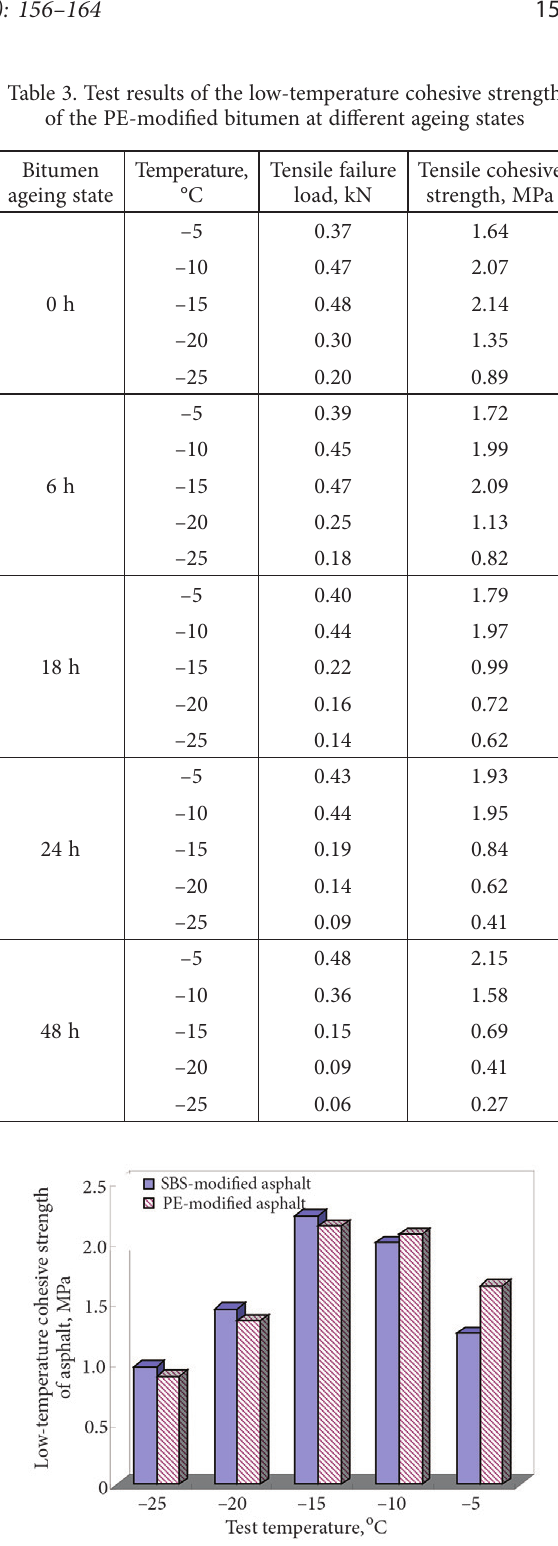
Figure 4. Change law of the two types of bitumen low-temperature cohesive strength after ageing for 0